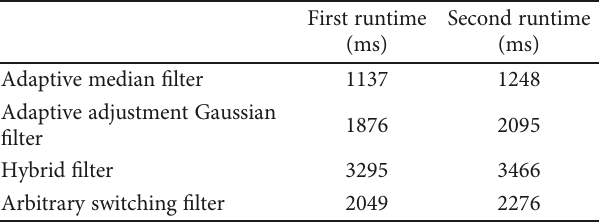
Table 3: Comparison of runtimes for di ff erent fi ltering